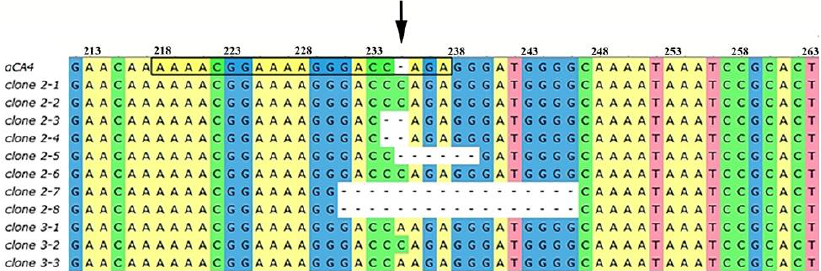
Figure 2. Alignment of the DNA sequences of the αCA4 gene in the region of the putative mutation. Designations: αCA4 is the sequence of the original gene; the numbers at the top are the numbers of the nucleotides in the gene; 20 bp in the frame is the sequence of the guide RNA ; Cas9 cleavage site is indicated by arrow; clones 2-1 – 2-8 are the clones of PCR fragments of the αCA4 gene from plant 2; clones 3-1 – 3-3 are the clones of PCR fragments of the αCA4 gene from plant 3 . To obtain homozygous lines carrying a mutation in the αCA4 gene, the offspring from self-pollination of plants 2 and 3 were planted in the soil and analyzed individually with primers Ath α CA4 Test1 F and Ath α CA4 Test1 R (See Materials and Methods). Among the analyzed 16 plants, one homozygous plant was identified. It corresponds to plant number 2.1. A PCR fragment of the αCA4 gene, which was obtained using DNA isolated from plant 2.1, after digestion by Asp S9I restriction enzyme, remained unchanged (Figure 3). This result indicated the presence of site-specific mutation in both copies of the target gene. Seeds collected from plant 2.1 (Crispr_α4) were used for further study.